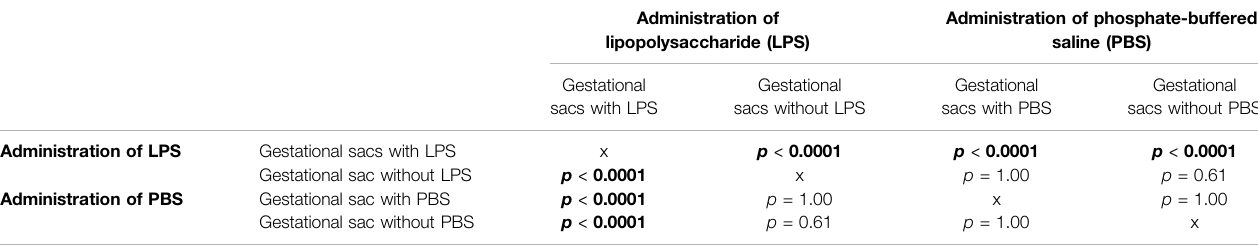
TABLE 1 | Comparisons of interleukin-6 concentrations in the amniotic fl uid from individual gestational sacs after an ultrasound-guided transabdominal intra-amniotic administration of either lipopolysaccharide or phosphate-buffered saline in rats.